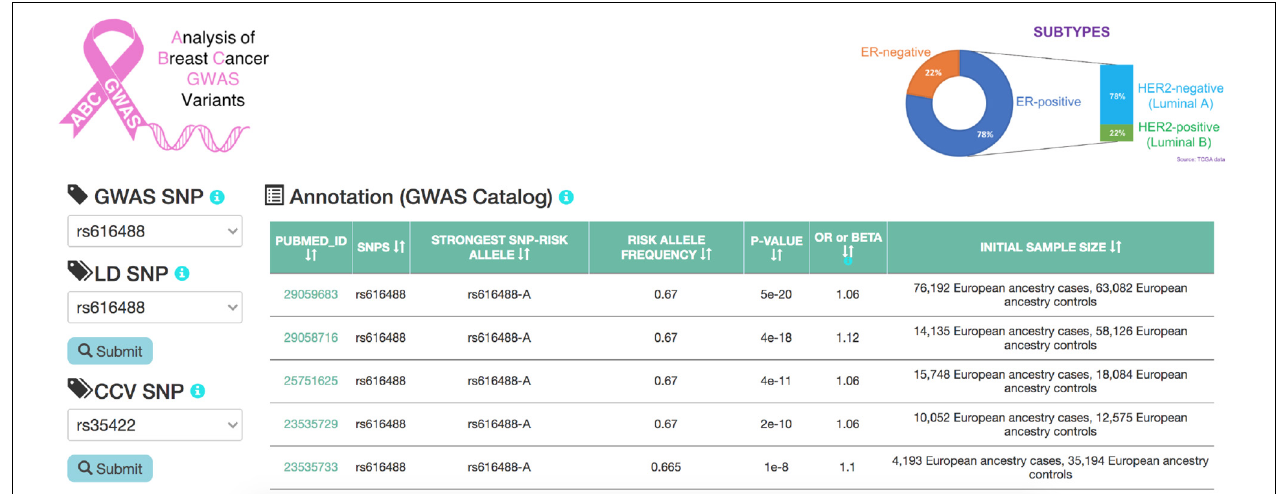
FIGURE 2 | A snapshot of the homepage of ABC-GWAS. Selecting a GWAS SNP using the left-hand-side drop-down menu populates the table on the right with relevant GWAS publications. Upon selecting an LD SNP or a CCV and clicking on the “Submit” button, various tabs on the bottom containing analysis modules are